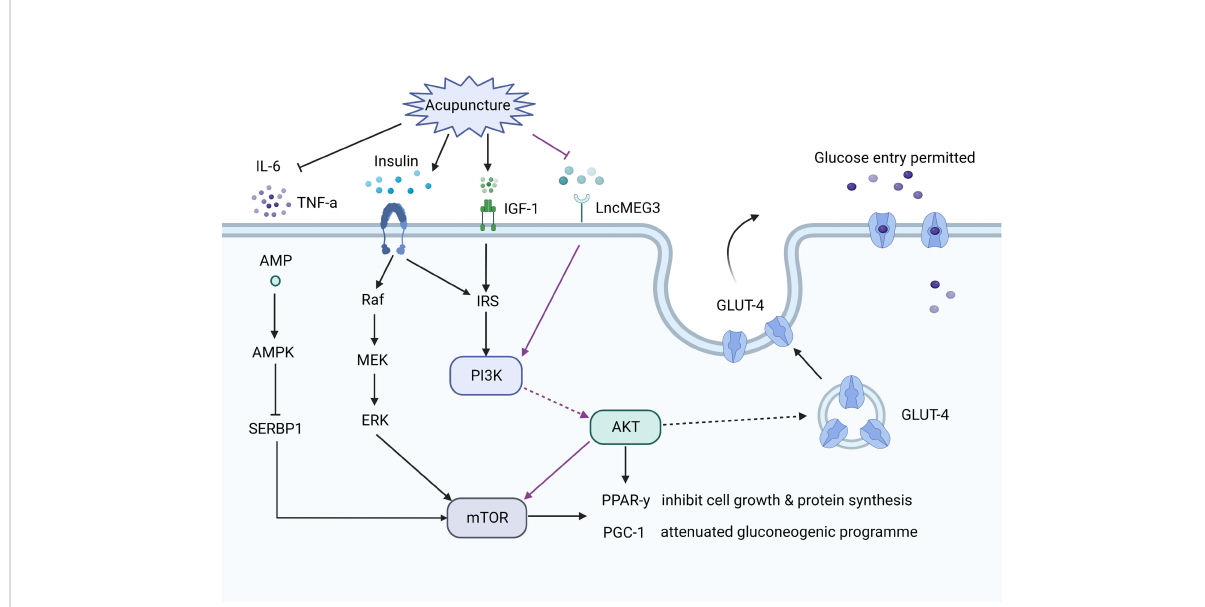
FIGURE 3 The effect of acupuncture on the insulin pathways. Acupuncture increases glucose transporter 4 (GLUT4) expression via upregulating the insulin receptor substrates-1/PI3K/GLUT4 pathway, or inhibiting the PI3K/AKT/mTOR pathway, or activating the adenosine monophosphate activated protein kinase (AMPK) pathway. Acupuncture also decreases the levels of linterleukin-6 and tumor necrosis factor- a , which are involved in insulin